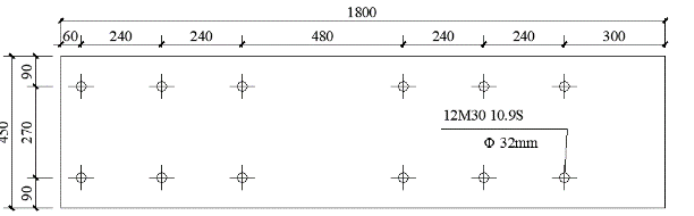
Figure 25. Detailed drawing of the 60 mm thick bottom connecting plate of specimen 2 (units: mm).